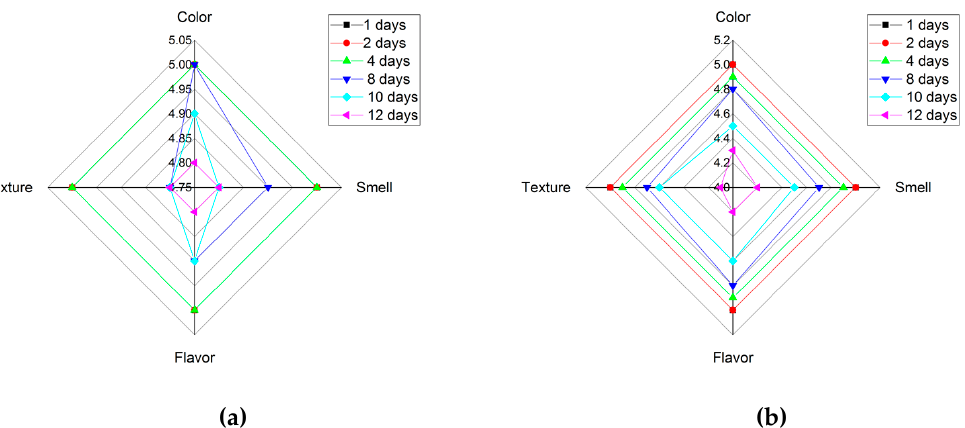
Figure 8. The sensory evaluation results in di ff erent home storage conditions. ( a ) The sensory evaluation results in refrigeration temperature. ( b ) The sensory evaluation results in room temperature.